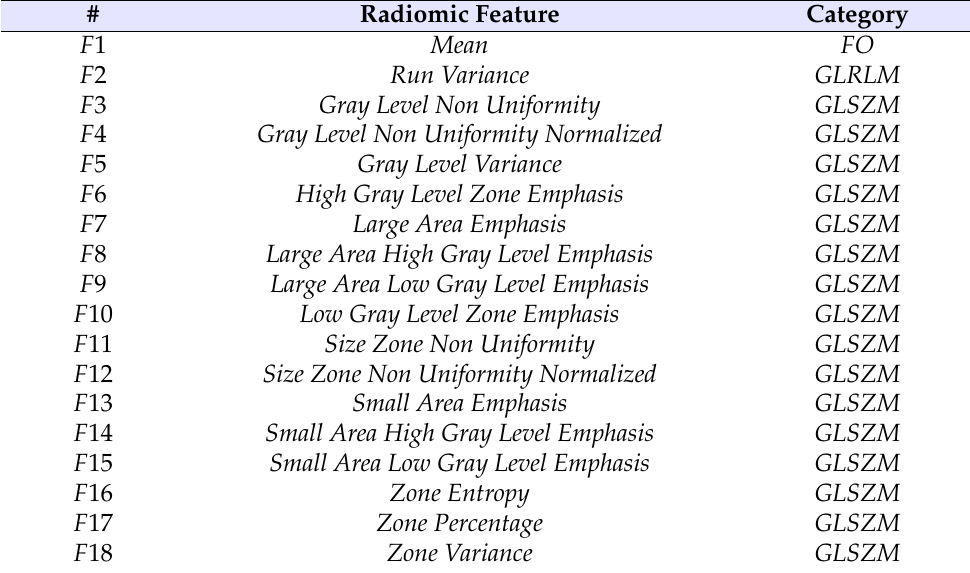
Table 1. The feature set with relative categories.